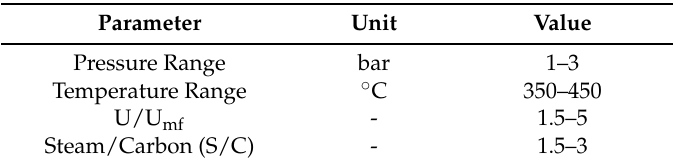
Table 2. Overview of the operating window for the experiments.